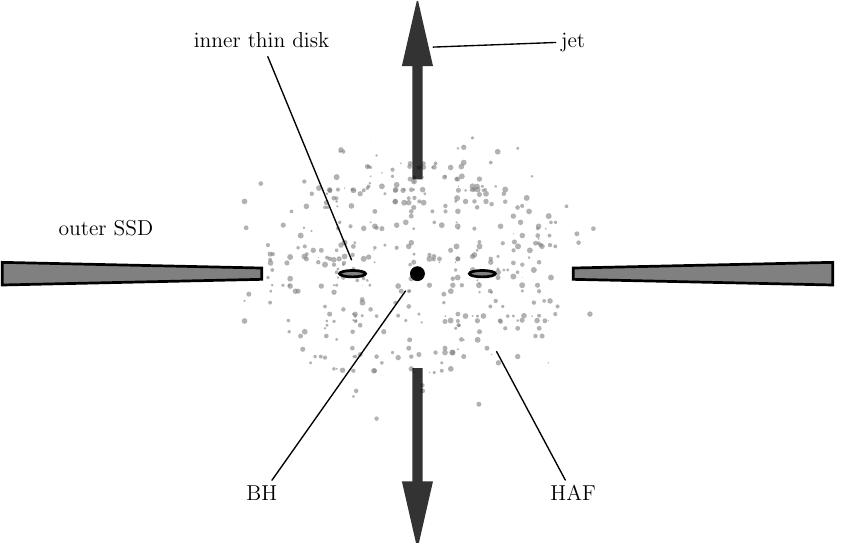
Figure 2. The schematic plot for a truncated disk with outer SSD and inside hot accretion flow (HAF) and the inner thin-disk component, as well as jets and central black